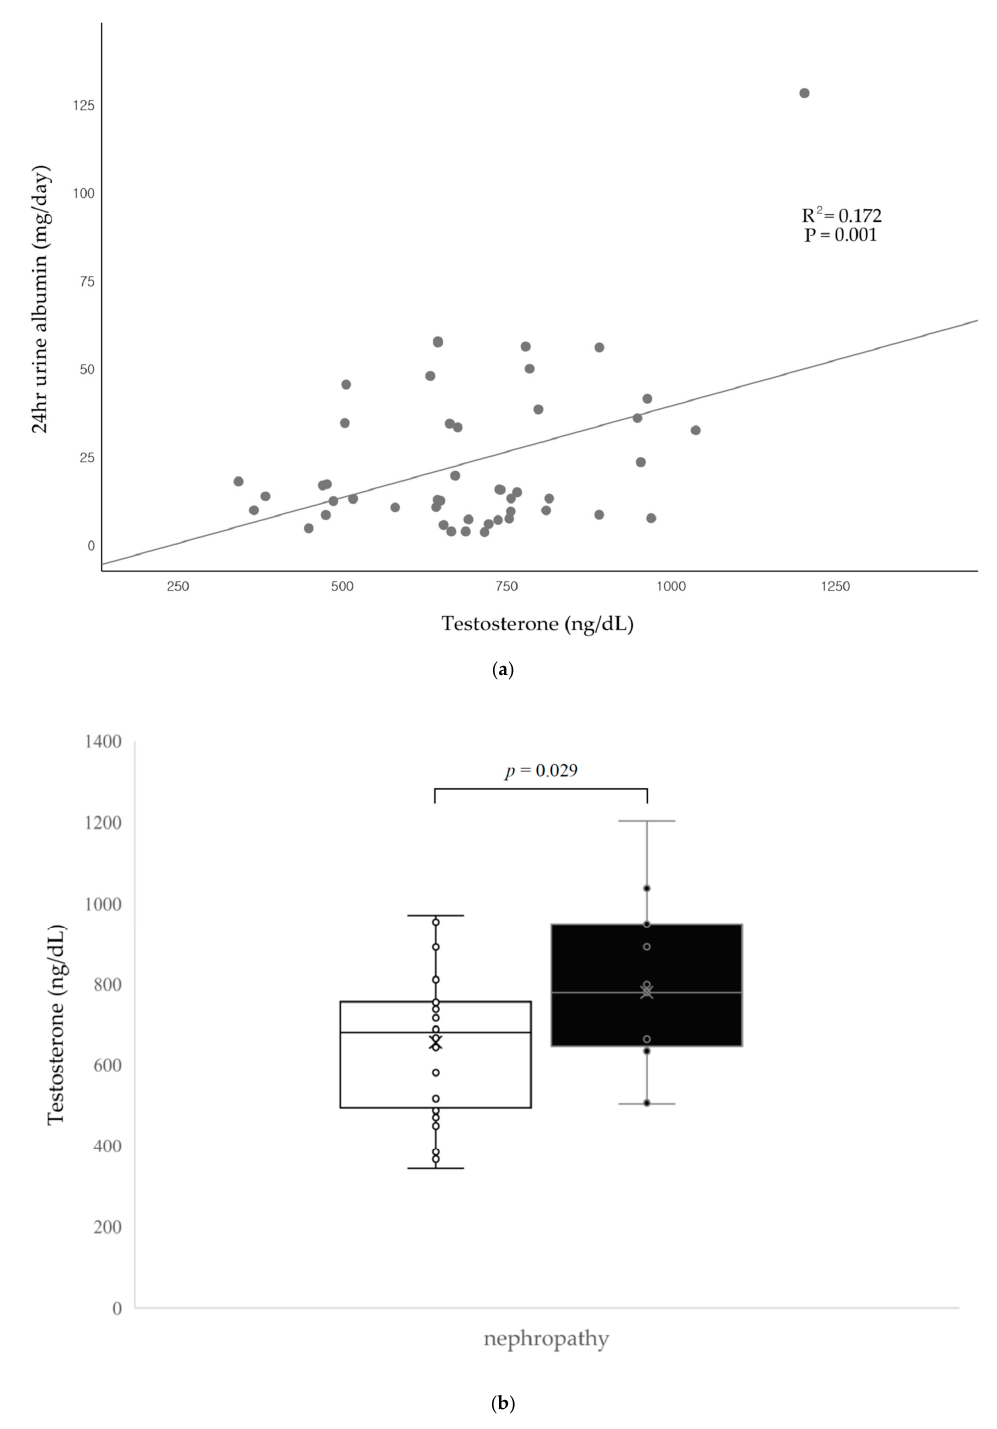
Figure 2. ( a ) The scatter plot and trend curve between total testosterone and 24 h urine albumin levels. ( b ) Testosterone levels of the study group according to nephropathy status. White, nephropathy; black, no nephropathy.